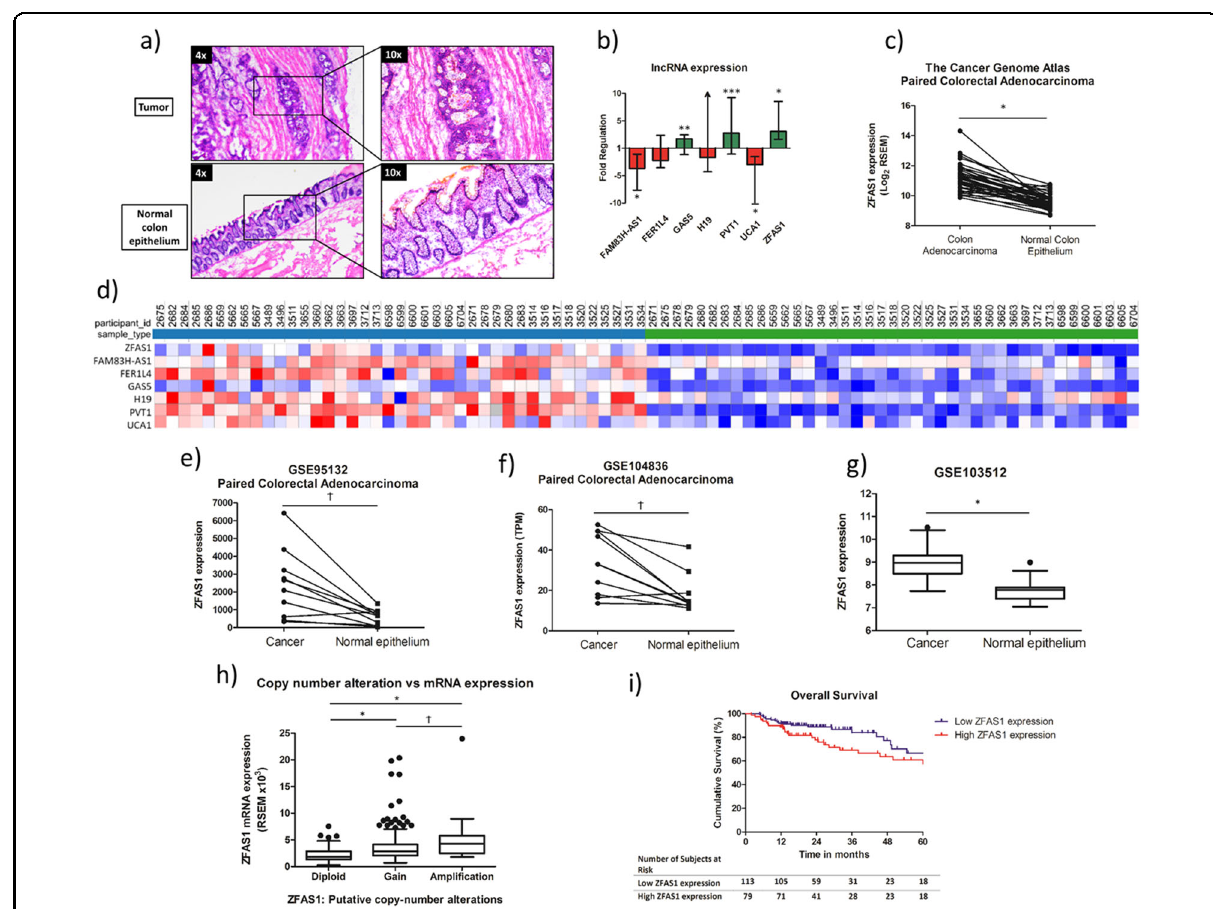
Fig. 1 Characterization of lncRNA expression in the TCGA data set and in an institutional data set, with a speci fi c focus on ZFAS1. a Example of a hematoxylin and eosin slide that was used as a guide for laser capture microdissection of the tissue from the University of Louisville Biorepository. b Fold regulaton of each of the seven selected lncRNAs examined by RTqPCR from LCM tissue from the University of Louisville Biorepository; FAM83H-AS1 (FR = − 3.68, * p < 0.001), FER1L4 (FR = − 2.22 p = 0.12), GAS5 (FR = 1.70, ** p = 0.021), H19 (FR = − 1.67, p = 0.84), PVT1 (FR = 2.75, *** p = 0.003), UCA1 (FR = − 4.85, * p < 0.001), ZFAS1 (FR = 3.06, * p < 0.001), ( n = 23 paired samples). c Scatter plot of ZFAS1 expression in colon cancer compared to paired normal colon epithelium examined by RTqPCR from LCM tissue from the University of Louisville Biorepository ( n = 23 paired institutional samples) (FC = 3.06, * p < 0.001). d Heatmap comparing the differential expression (RSEM quanti fi cation) between paired colon adenocarcinoma and normal colon epithelium of the seven lncRNAs using RNAseq expression data from the Cancer Genome Atlas ( n = 40 paired samples). e Increased ZFAS1 expression in cancer compared to paired normal colon epithelium in the GEO GSE95132 RNA-seq dataset ( n = 10 paired samples, RNA-seq expression, units = TPM) ( Ϯ p = 0.009). f Increased expression of ZFAS1 in cancer compared to paired normal colon epithelium in the GEO GSE104836 RNA-seq dataset ( n = 10 paired samples, units = normalized RNAseq expression) ( Ϯ p = 0.009). g Increased expression of ZFAS1 in colon cancer compared to unpaired colon epithelium in the GEO GSE103512 array dataset ( n = 70 Affymetrix array expression, units =